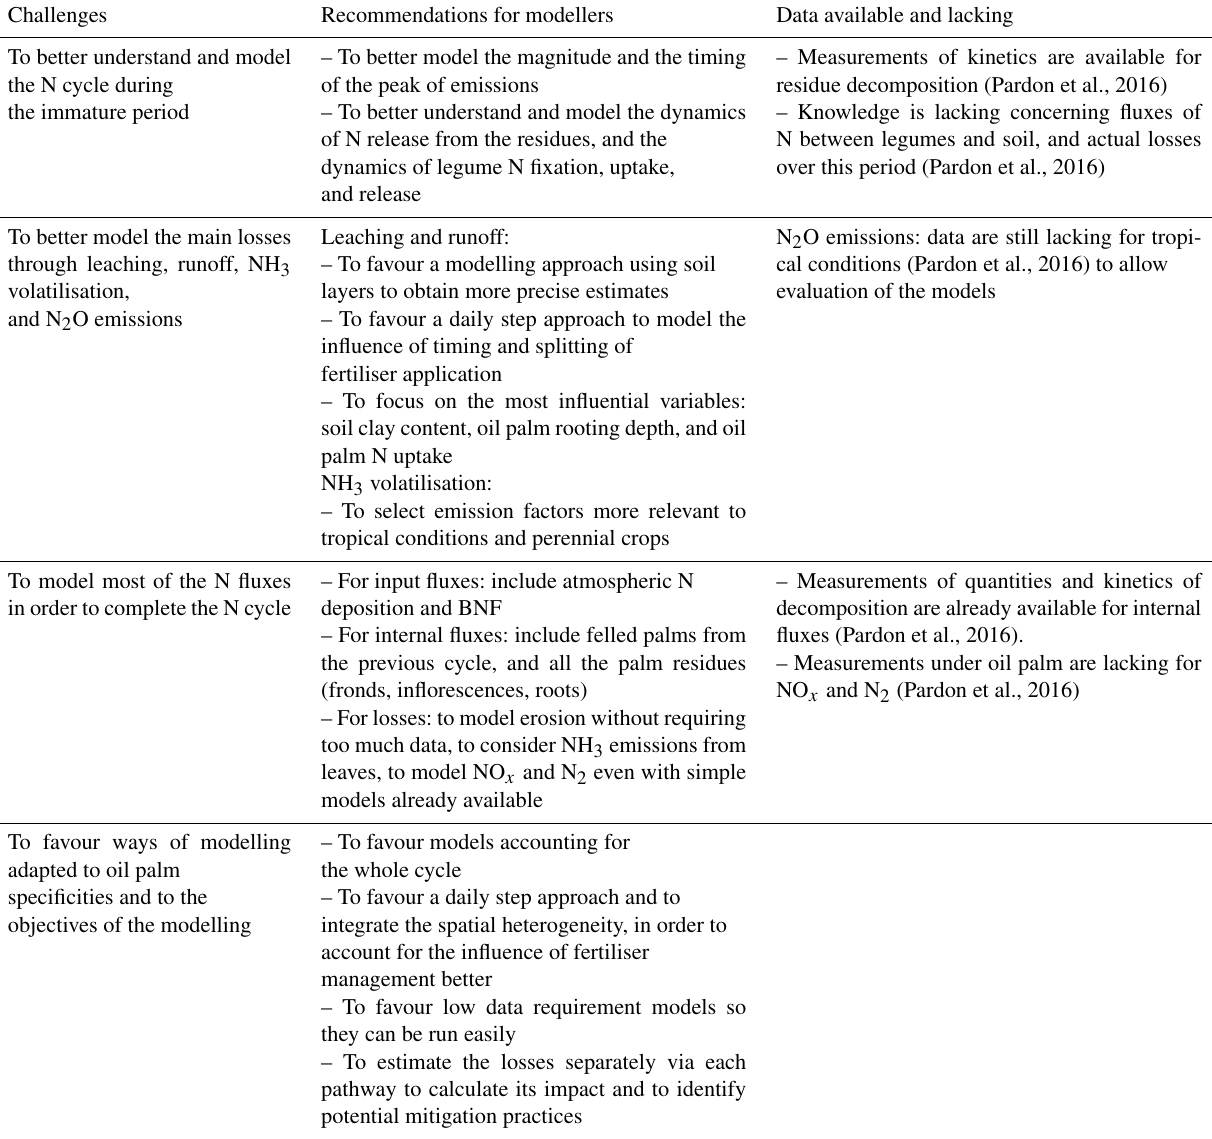
Table 2. Synthesis of the challenges identified in modelling the N cycle in oil palm plantations. BNF: biological N fixation.